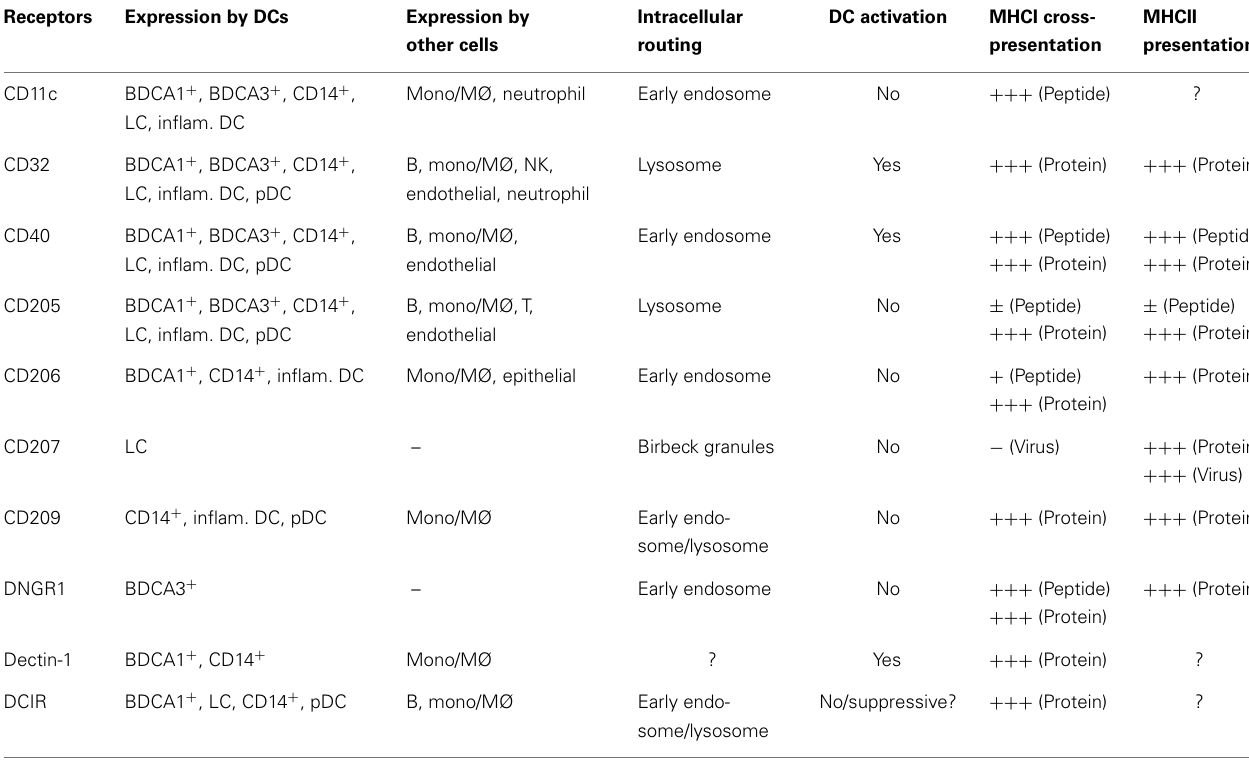
Table 1 | Expression, intracellular localization, and ability to deliver antigen to MHCI and MHCII pathways of selected endocytic receptors and antigen